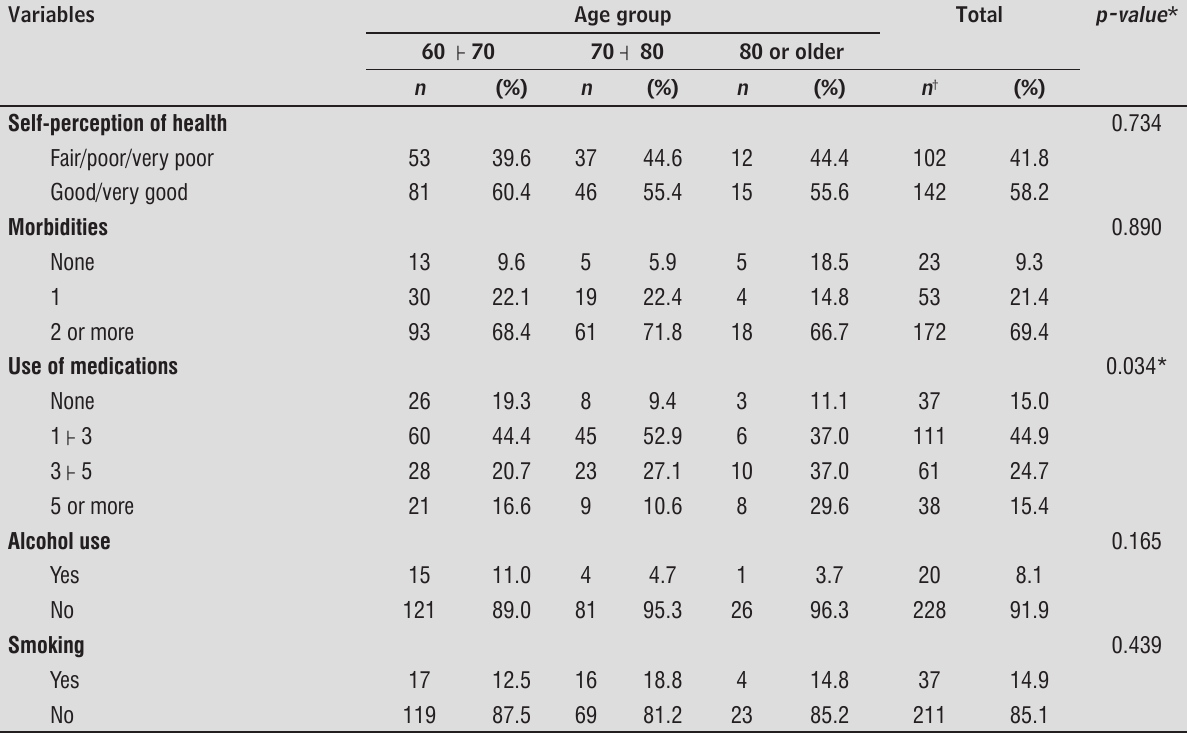
Table 2 - Distribution of clinical and health variables by age group. Uberaba, MG, Brazil, 2011